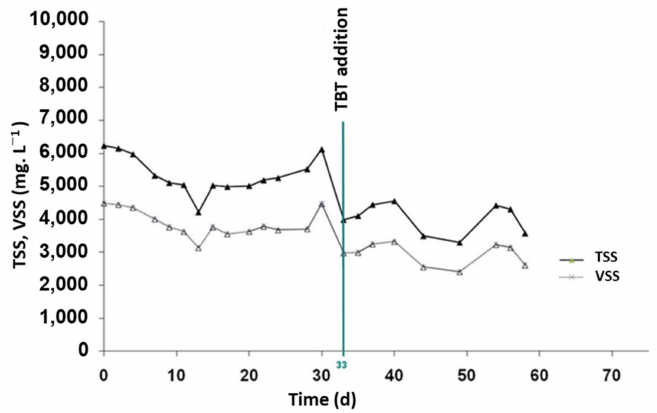
Figure 6. Evolution in TSS et VSS concentration in MBRi